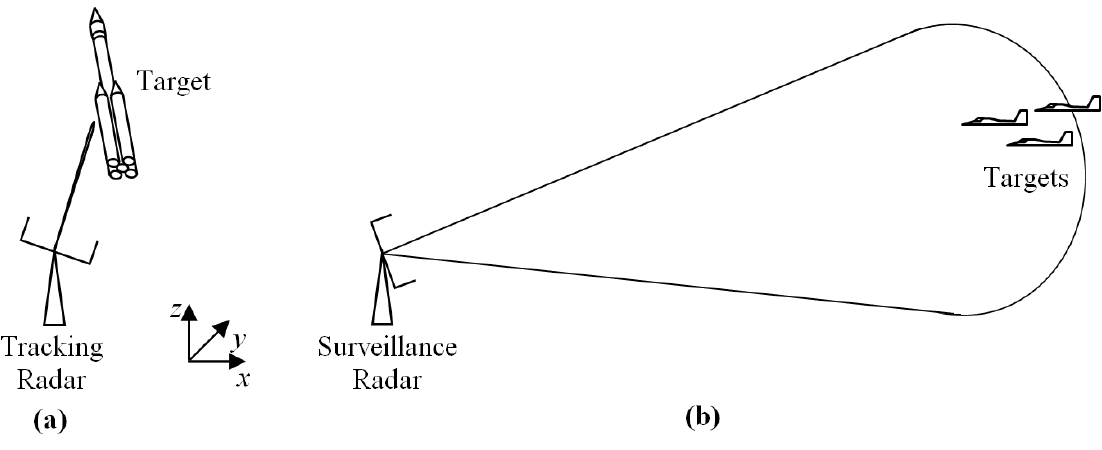
Figure 2. ( a ) Rocket tracking radar near launch pad. ( b ) Surveillance radar for remote control air